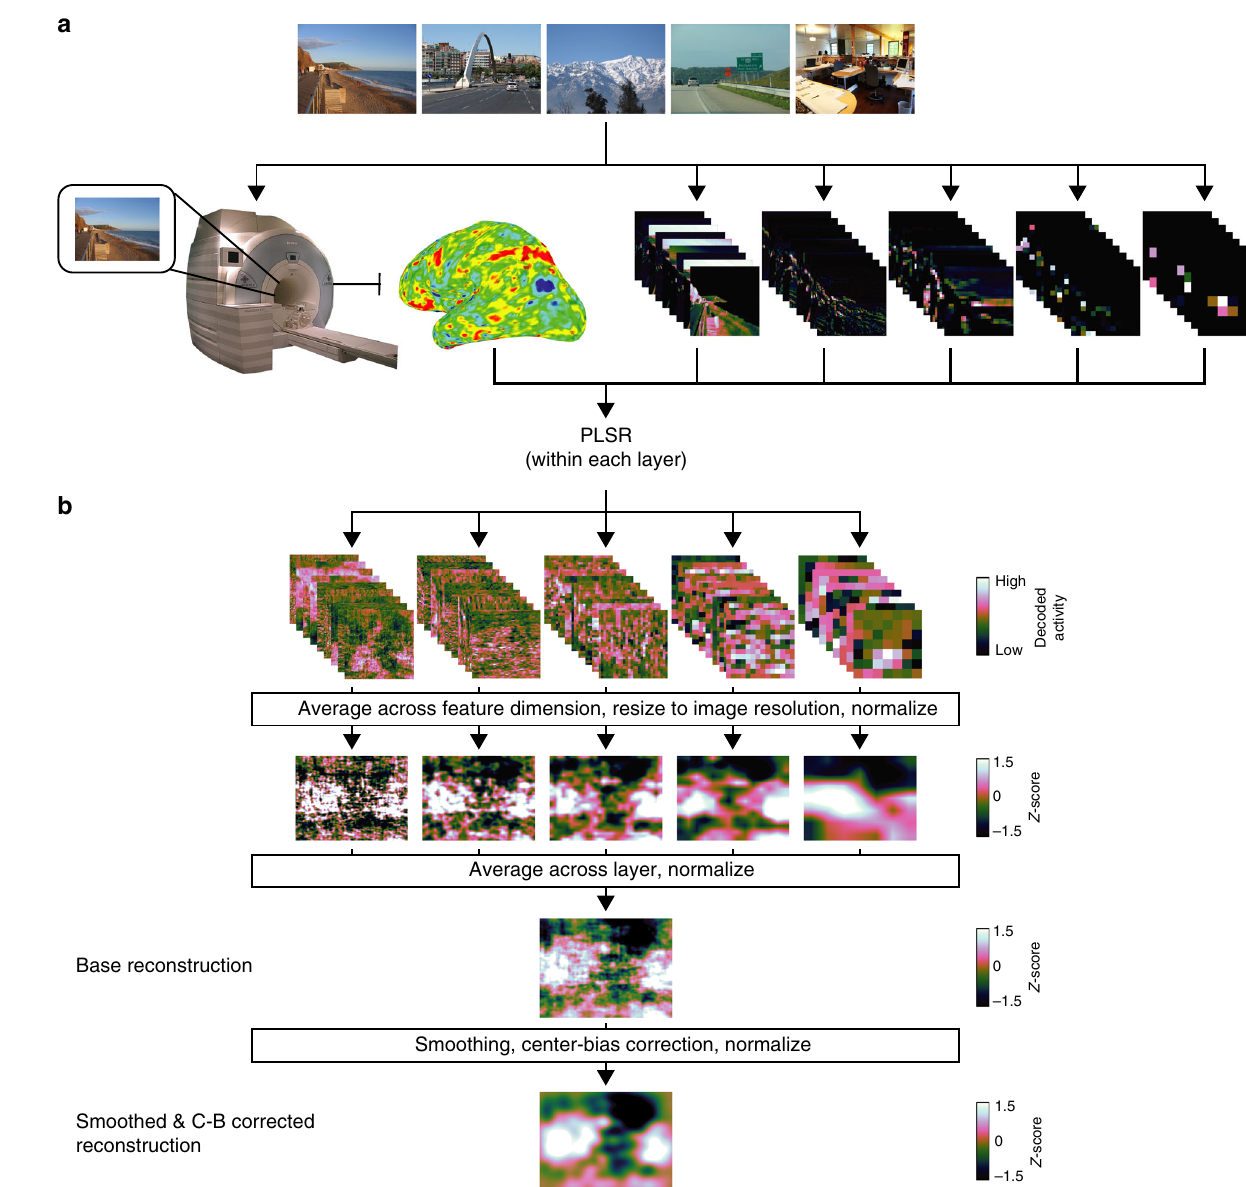
Fig. 4 Model-based pipeline to reconstruct spatial priority maps. a fMRI was used to measure evoked activity for each image in the experiment. Each image was parameterized into a CNN feature-space. We learned the transformation between fMRI activity and CNN activity separately for each CNN layer using PLSR in a LORO cross-validated fashion. These learned transformations were applied to left-out data to align fMRI activity to CNN activity from each layer. b To reconstruct spatial priority maps from CNN-aligned fMRI activity, we applied the spatial attention model developed on computational CNN activity. CNN-aligned fMRI activity from each layer was averaged across the feature-based dimension to produce reconstructed layer-speci fi c activity maps, which were then averaged together to produce a reconstructed spatial priority map for each image (base reconstruction). In a separate analysis, the reconstructions were smoothed with a 2D Gaussian kernel (SD = 24 px) and pointwise multiplied by a centered 2D Gaussian kernel (600 × 600 px, SD = 600 px, resized to image resolution of 600 × 800 px) to account for center-bias (smoothed and center-bias corrected